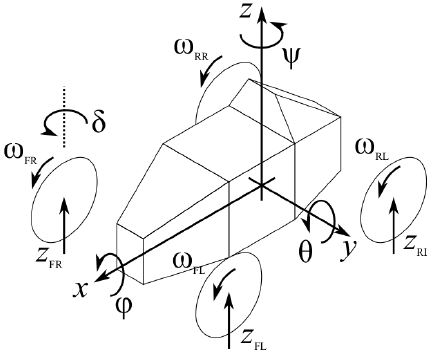
Figure 2. Fourteen degrees of freedom (14 dofs) vehicle model.